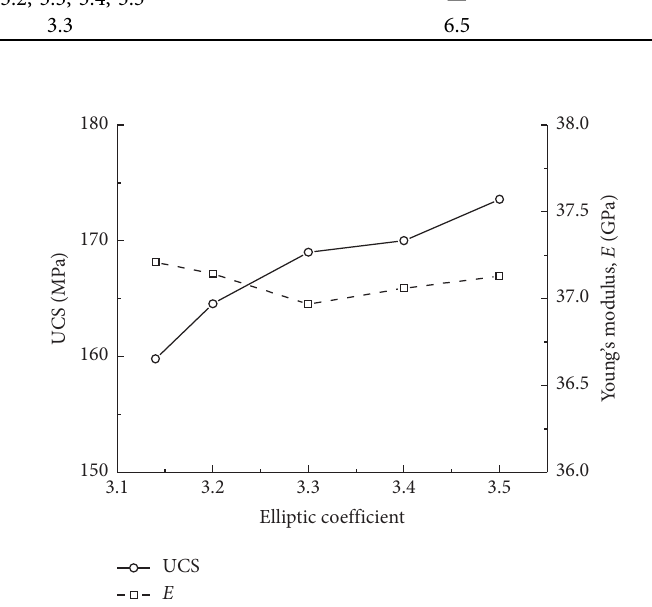
Figure 8: Relationships between the UCS, Young’s modulus, and elliptic coefficient.